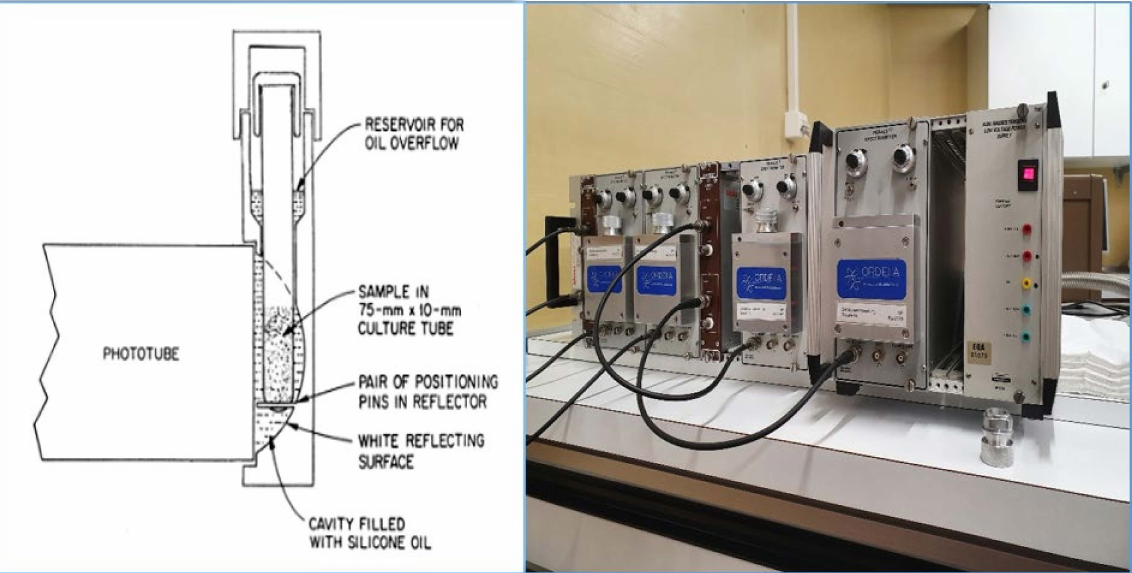
Figure 2. ( Left ): Scheme of the PERALS cell with the photo tube, ORDELA model 8100AB-HV (taken from [8] with kind permission of ORDELA Inc.). ( Right ): A series of four PERALS counters (photo by M. Zehringer).